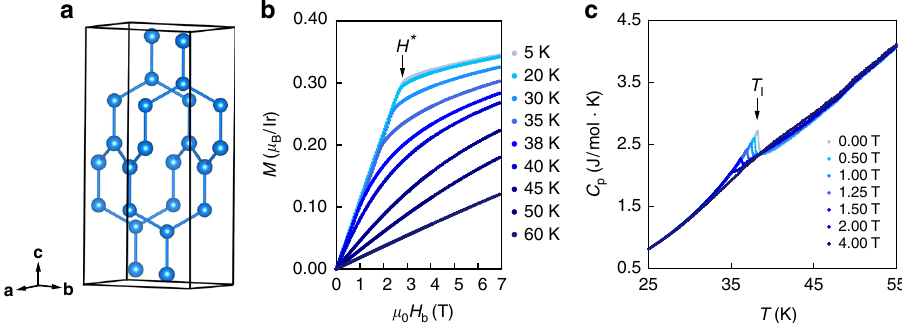
Fig. 1 β -Li 2 IrO 3 structure and thermodynamic properties. a 3D projection of a unit cell. The Ir atoms (blue balls) form zig-zag chains stacked along the c -axis and directed alternatingly along the a ± b directions. b Magnetization vs. magnetic fi eld applied along the b -axis, for temperatures up to 60 K. The low temperature data shows a kink at H *. c Heat capacity as a function of temperature for fi elds up to 4 T. The data shows a triangular anomaly around the transition at T